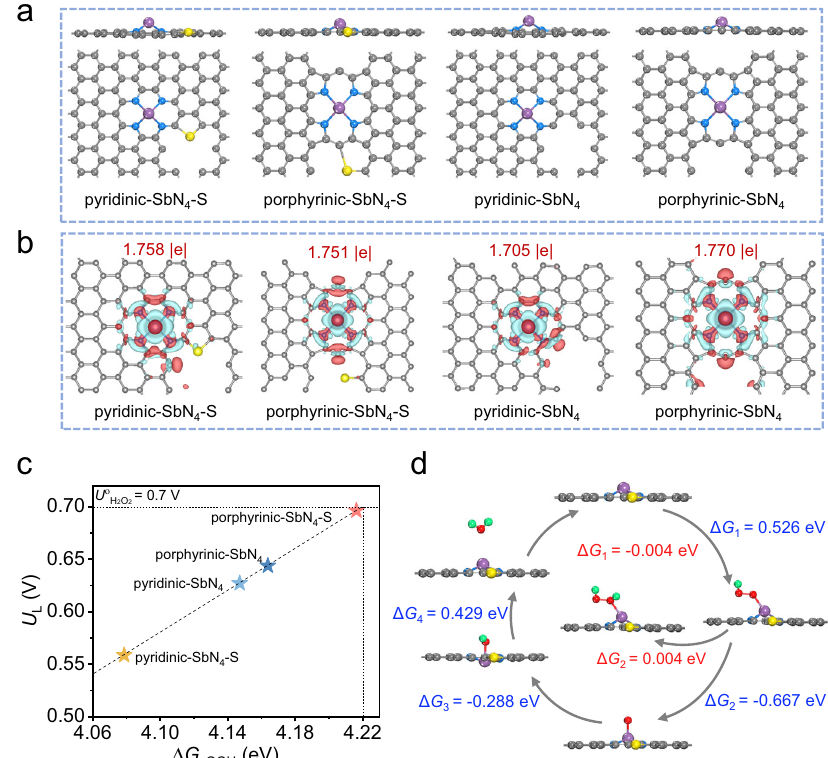
Fig. 5 | Theoretical analysis. a The side and top views of optimized structural models of pyridinic-SbN 4 -S, porphyrinic-SbN 4 -S, pyridinic-SbN 4 , and porphyrinic- SbN 4 . The gray, blue, yellow, and purple spheres represent C, N, S, and Sb atoms, respectively. b The calculated charge density difference for the corresponding structural modelsin ( a ).The red and cyanisosurfaces (0.003 Bohr -3 ) represent the